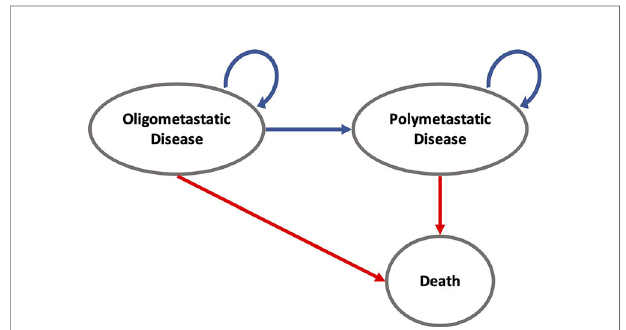
FIGURE 1 | State-transition diagram for modeling cost and effectiveness for the SABR and SC strategies over time intervals. For example, patients in the oligometastatic disease state can either remain in the oligometastatic state, transition to the polymetastatic disease state, or die. Death is an absorbing state and will discontinue the individual